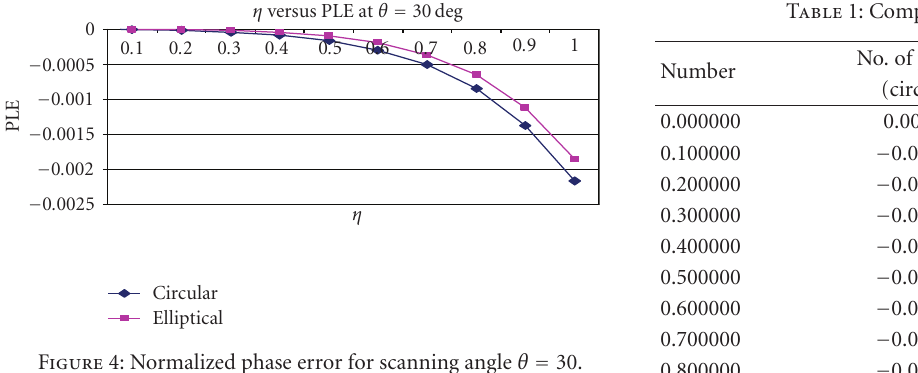
Figure 4: Normalized phase error for scanning angle θ = 30.